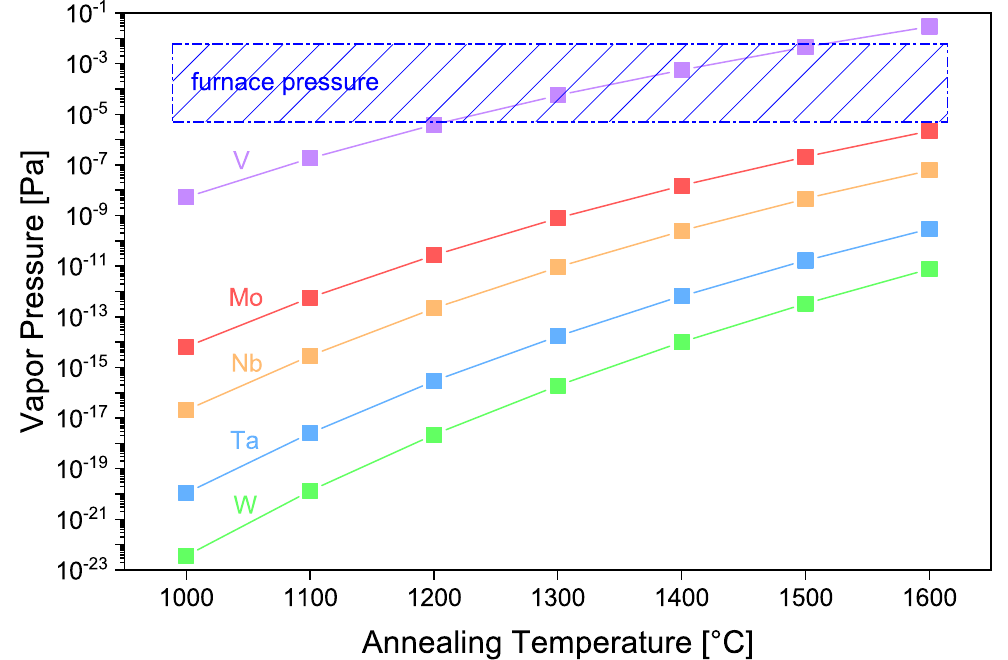
Figure 3. Calculated vapor pressure of the constituting elements are depicted according to their respective annealing temperature